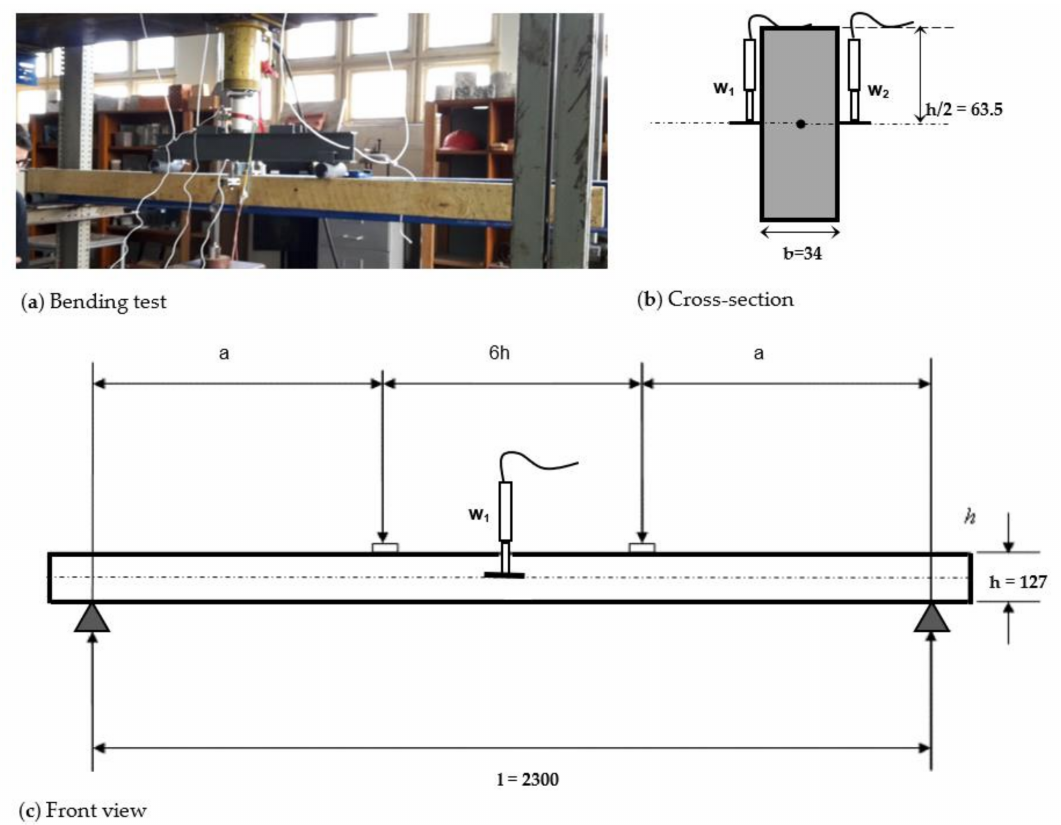
Figure 1. Four-point bending test of sawn boards: ( a ) bending test, ( b ) cross-section, and ( c ) front view (dimensions in